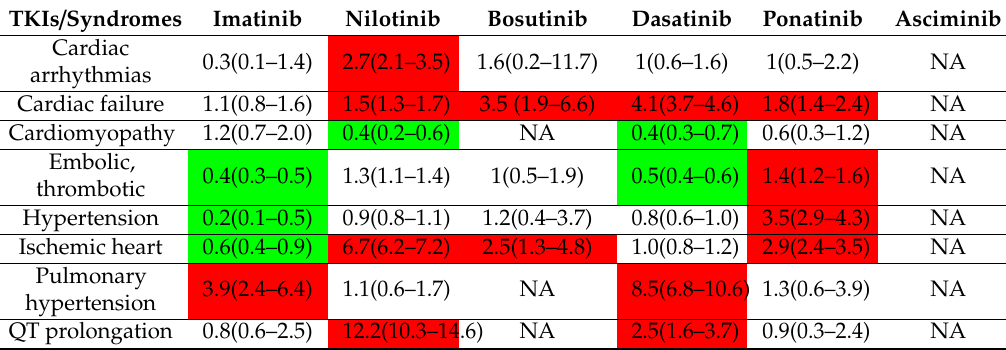
Table 3. CML TKIs and their risk for adverse cardiovascular